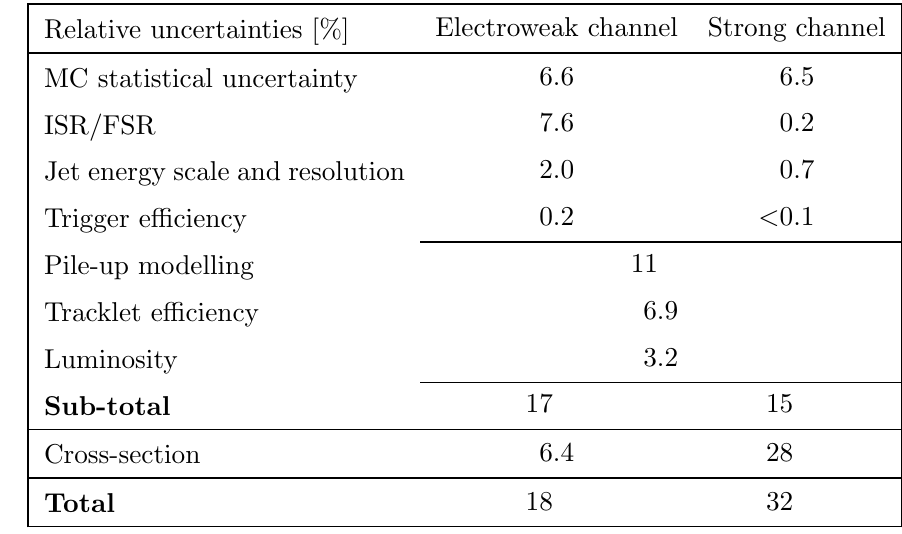
Table 3 . Systematic uncertainties in the signal event yields at m = 400 GeV for the electroweak ~ (cid:31) (cid:6) 1 channel and at m ~ g = 1600 GeV, m = 500 GeV for the strong channel. The lifetime of the chargino ~ (cid:31) (cid:6) 1 is not relevant here. The uncertainty in the cross-section of the strong production is large due to the large e(cid:11)ect from the PDF